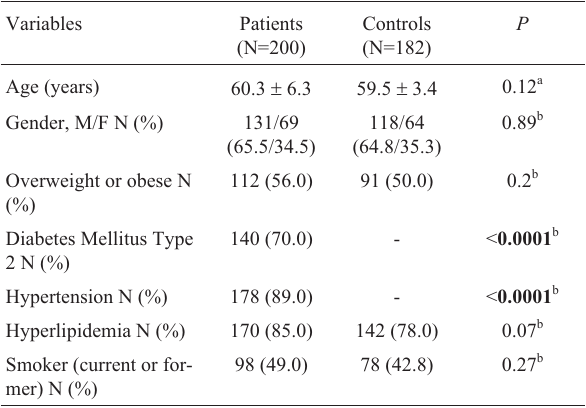
Table 1 - Demographic and clinical characteristic of atherosclerosis pa- tients and controls.